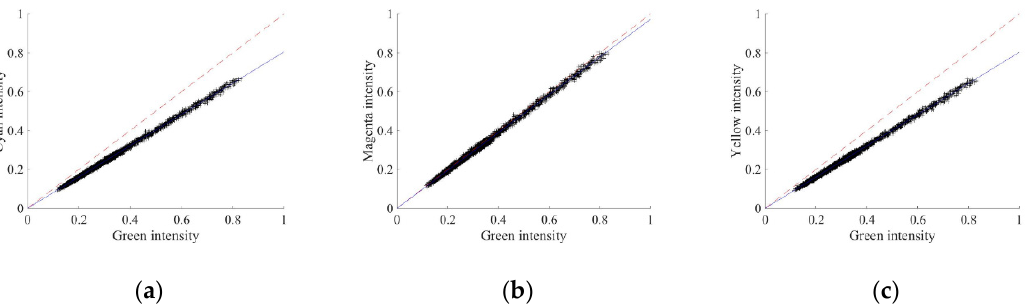
Figure 2. The Near-infrared (NIR) intensity scatter plot between two different color channels ( a ) Green-Cyan, ( b ) Green-Magenta, and ( c )